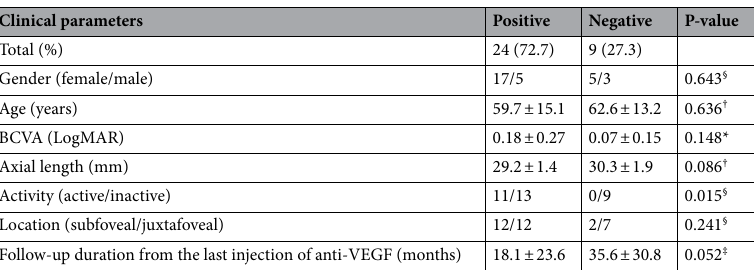
Table 3. Comparison of characteristics between eyes with or without choriocapillaris flow deficit around choroidal neovascularization. OCTA optical coherence tomographic angiography, BCVA best-corrected visual acuity, VEGF vascular endothelial growth factor, LogMAR logarithm of the minimum angle of resolution. † Student’s t -test; *Welch’s t -test; ‡ Wilcoxon rank sum test; § Fisher’s exact test.